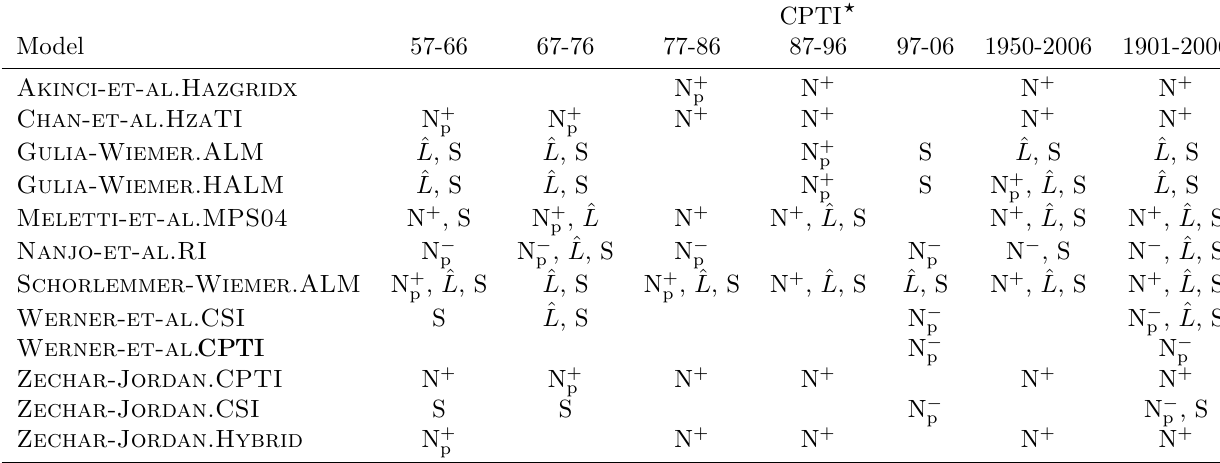
Table 3. Summary results of the forecast tests obtained using the CPTI. *For each model and each experiment time period, the tests that the forecast failed are indicated, according to a 5% critical significance value. For the N-Test, N + indicates that the forecast overpredicted the observed rate, N – indicates underprediction; the subscript p indicates that the forecast only failed when assuming a Poisson uncertainty; otherwise it failed under both the Poisson and